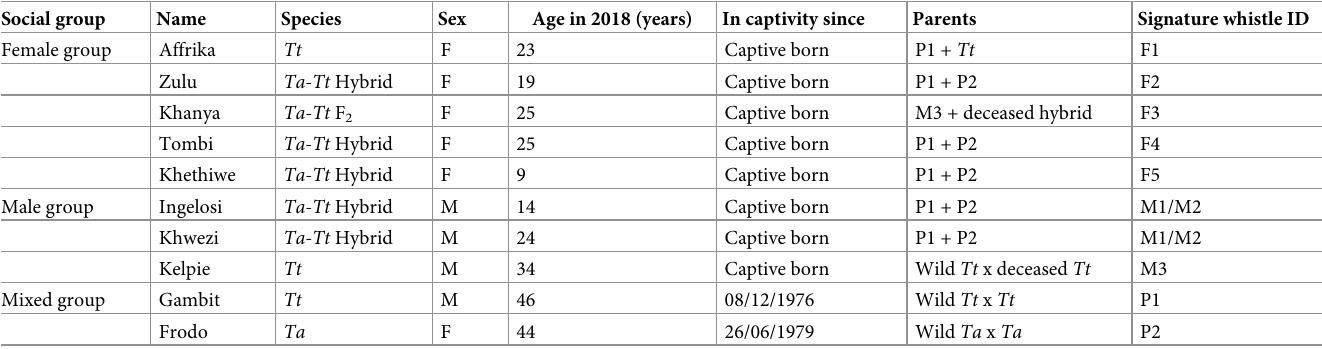
Table 1. Genetic, social grouping and individual data for the dolphins at uShaka Sea World in 2018 (adapted from [50]). Social